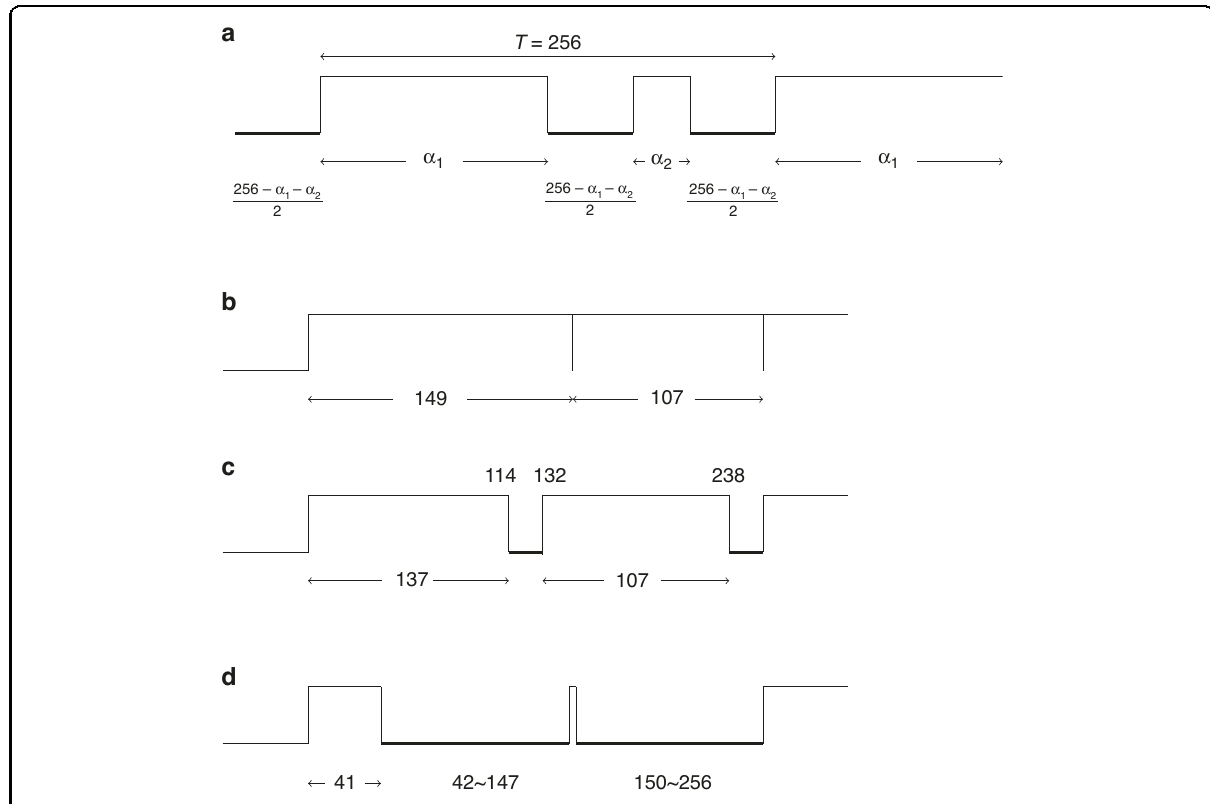
Fig. 6 LCD PWM design for C 235 . a Generation of pulse widths in PWM. b For width 256 = 149 + 107, 2 off(0,0) . c For width 220 = 113 + 107, 2 off(114~132, 238~256) . d For width 44 = 41 + 3, 2